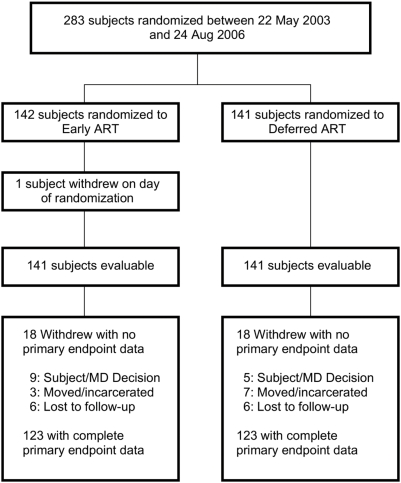
Study Subject Enrollment and Discontinuation.